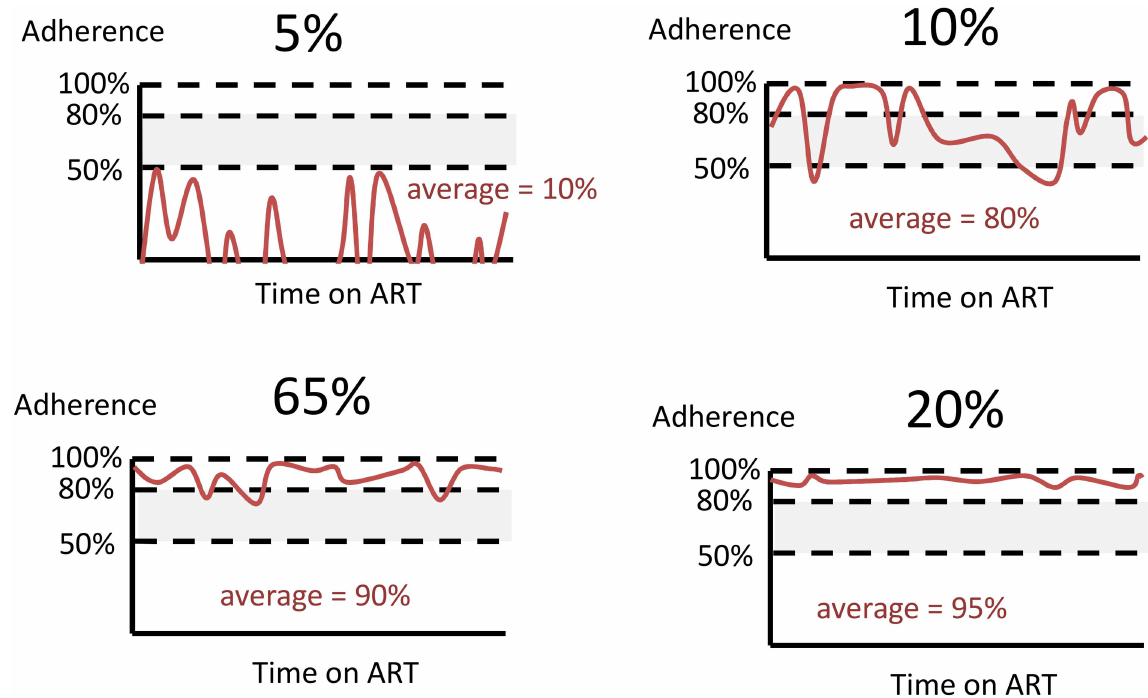
Fig 1. Modelling of distribution of adherence patterns over individuals in the